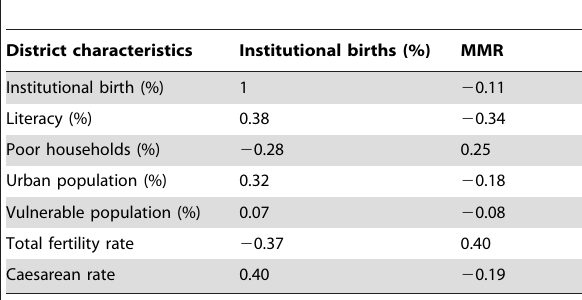
Table 2. Correlation: district characteristics, proportion of institutional births and MMR.